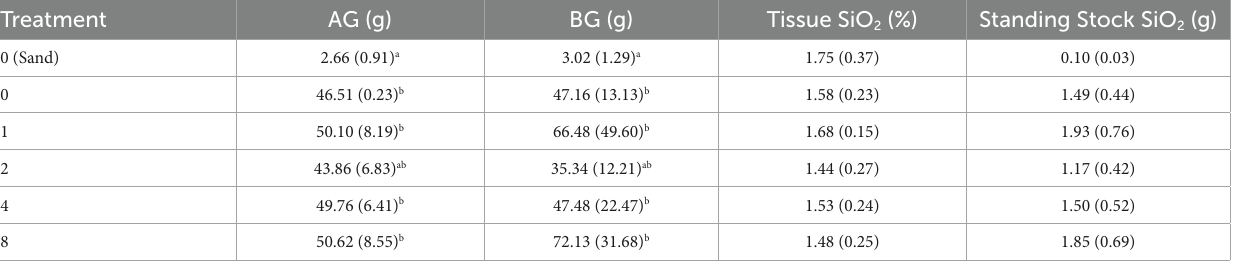
TABLE 5 Results at the conclusion of the 2012 laboratory (phytotron) experiment showing mean (± standard deviation, n = 10 containers) aboveground (AG) and belowground (BG) Spartina alterniflora biomass (g per 2.4 l container), S. alterniflora tissue SiO 2 concentration (%) and SiO 2 standing stock